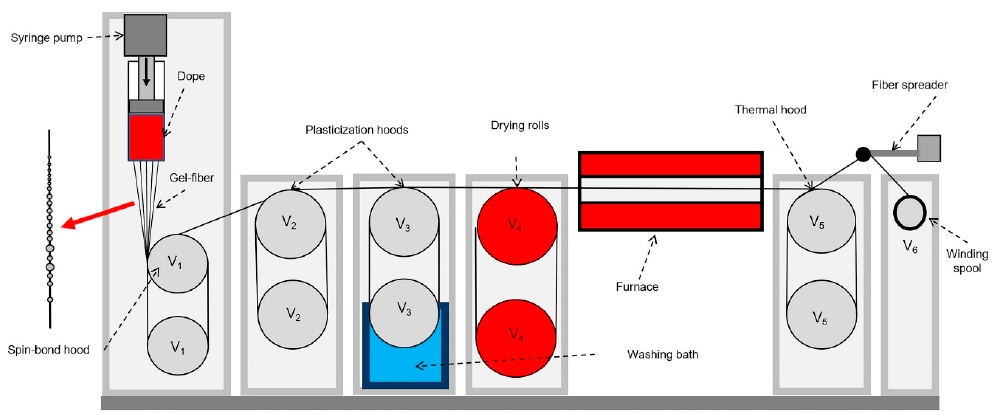
Figure 1. Scheme of the mechanotropic spinning line. V 0 is the outflow velocity from the die; V 1 –V 6 are the rotation speeds of the rolls.